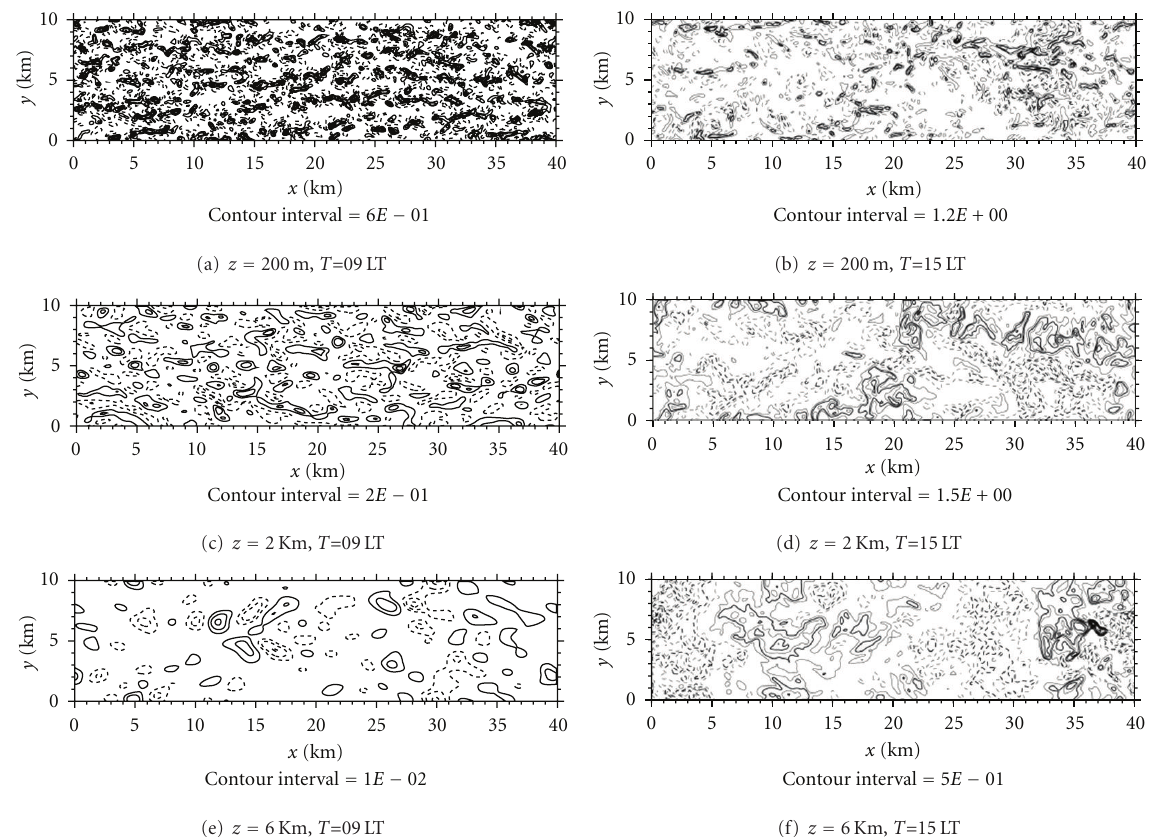
Figure 4: The same as Figure 3 except for the EXP2 case. Note that the contour intervals are di ff erent from those in Figure 3 for (c).